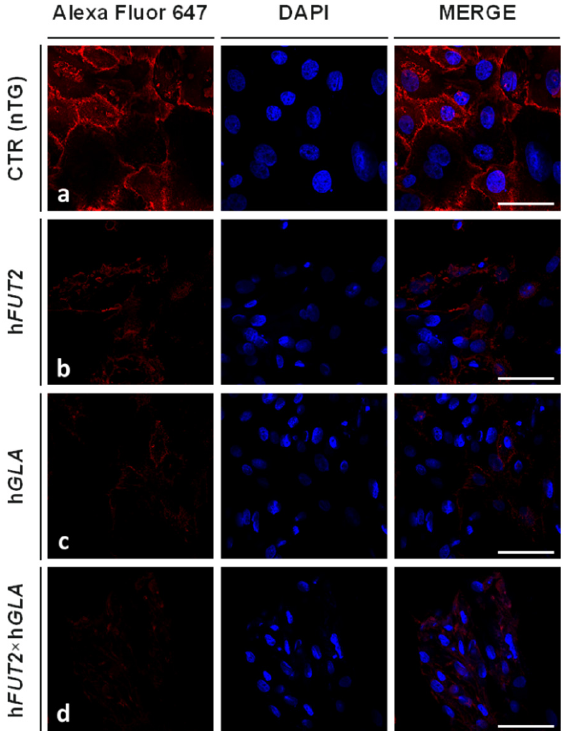
Figure 4. Lectin fluorescence analysis of expression profiles specific for Gal α 1 → 3Gal epitopes in ex vivo-expanded PEKs stemming either from genetically nontransformed pigs designated as CTR nTG group ( a ) or from different types of genetically transformed pigs as follows: h FUT2 mono-transgenic ( b ), h GLA mono-transgenic ( c ) and h FUT2 ×h GLA bi-transgenic ( d ). Representative microphotographs depicting incidences of fluorocytochemically recognizing lectin GS I-B 4 -labelled Gal α 1 → 3Gal antigenic determinants localized in intracellular compartments and plasma membranes of PEKs from each experimental variant specified as: CTR nTG ( a ), h FUT2 single-transgenic ( b ), h GLA single-transgenic ( c ), and h FUT2 ×h GLA double-transgenic ( d ). The lectin fluorescence analysis was accomplished by using Alexa Fluor 647-conjugated lectin GS I-B 4 (highly specific red fluorocyto- chemical tagging of Gal α 1 → 3Gal antigenic determinants) and 4 (cid:48) ,6-diamidino-2-phenylindole (DAPI) counterstain (blue dyeing of the cell nuclei). Scale bars represent 100 µ m.